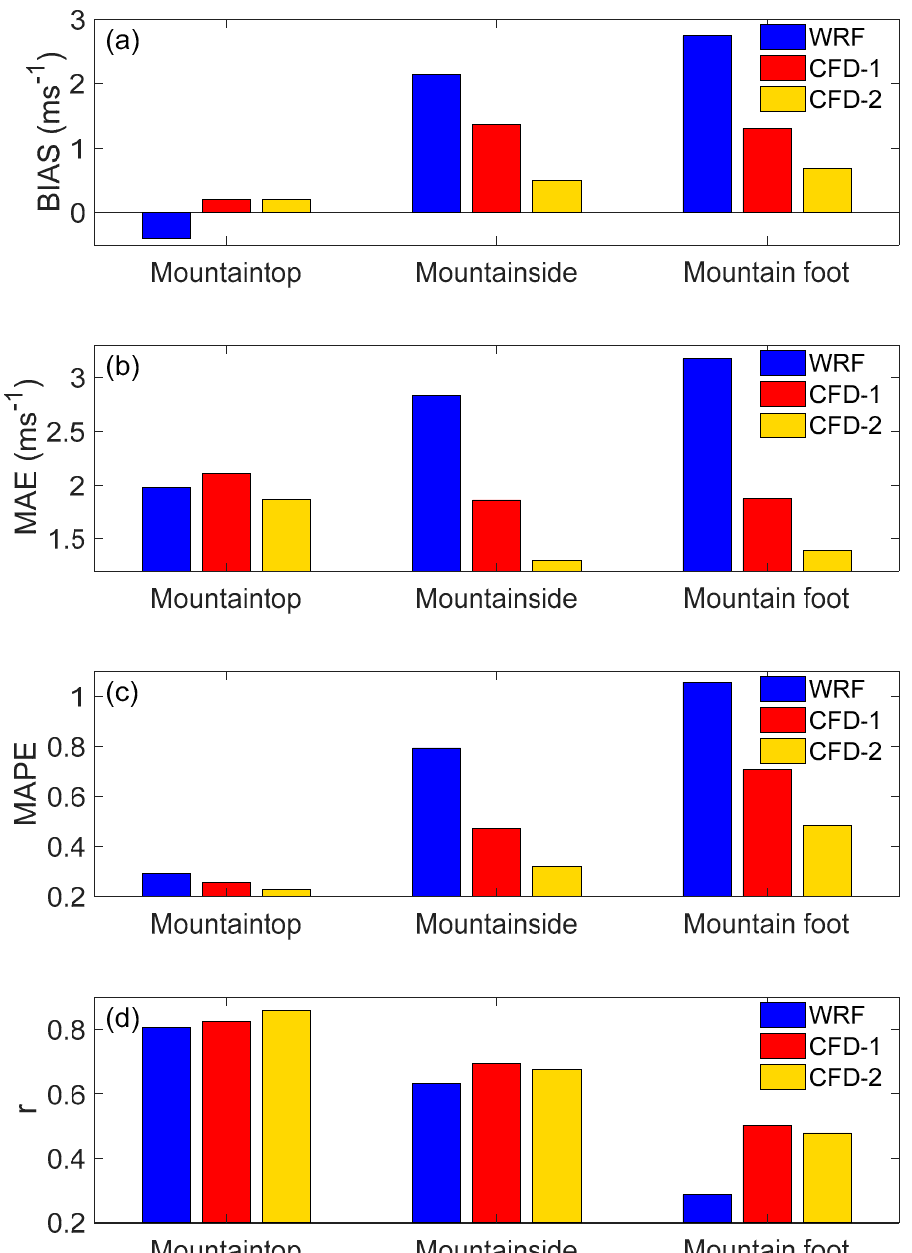
Figure 7. Calculated results of the sensitivity analysis for different models’ simulations, four indexes (( a ) systematic deviations from expected values (BIAS), ( b ) mean absolute error (MAE), ( c ) mean absolute percentage error (MAPE), and ( d ) temporal correlation coefficient ( r )) are considered.